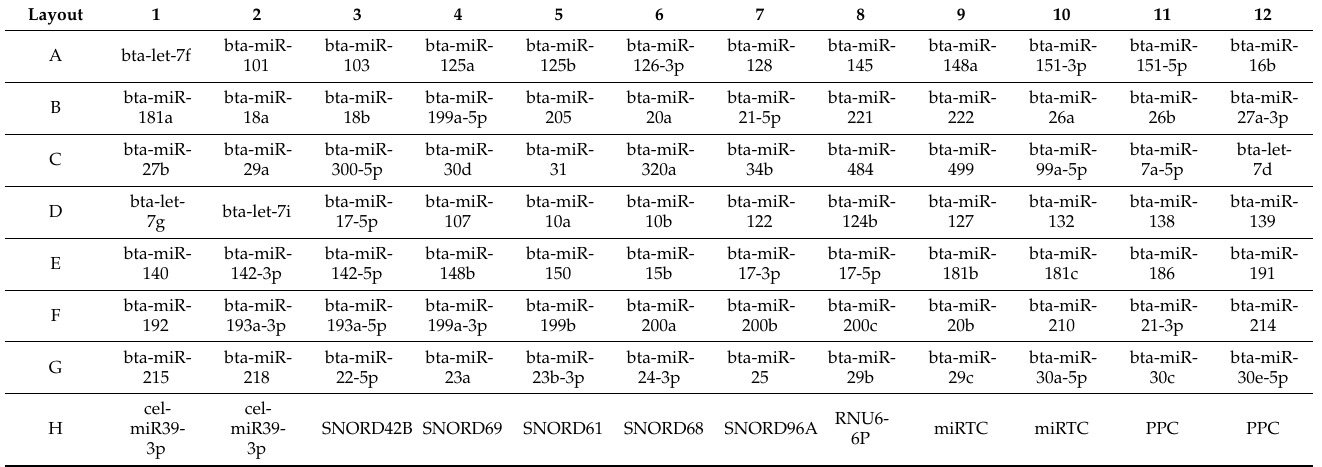
Table 1. Bovine miRBase profiler plate, consisting of primers for 84 target miRNAs and control